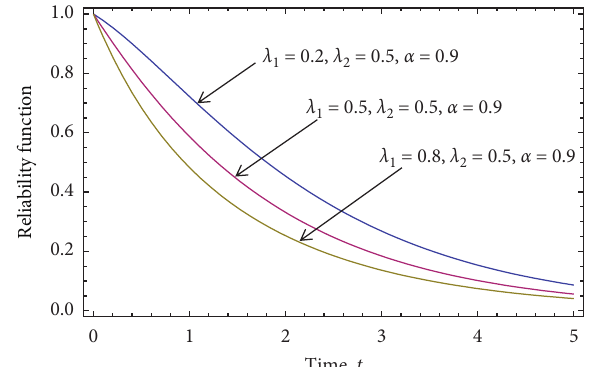
Figure 2: System reliability versus failure rate λ